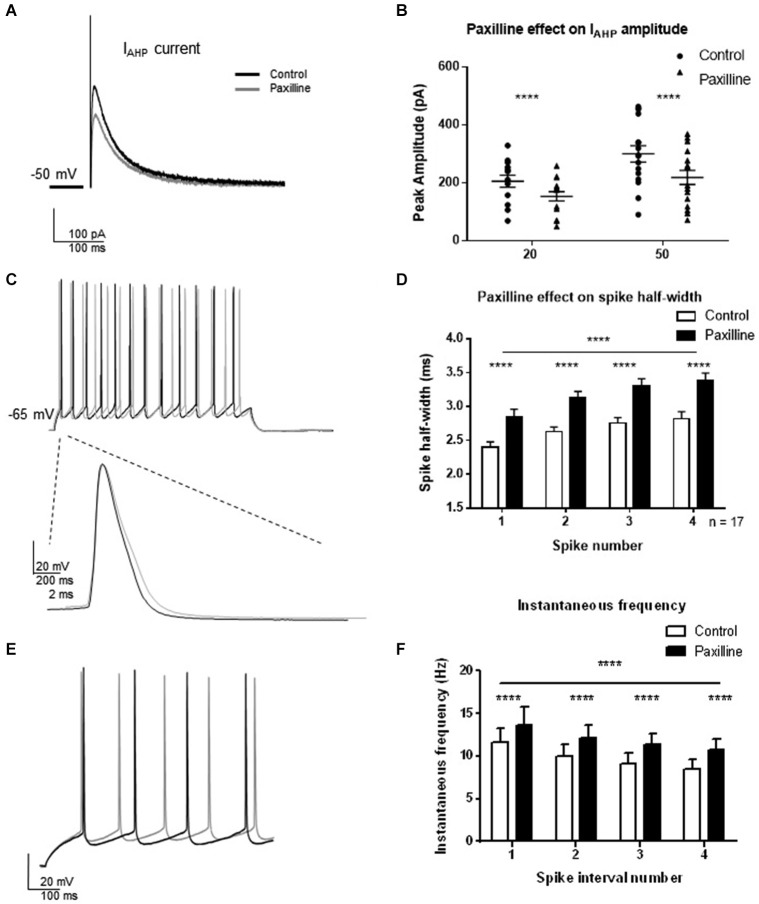
Direct blockade of BK channels with paxilline application decreased IAHP and increased spike half-width and instantaneous frequency. (A) Paxilline application significantly reduced IAHP amplitude compared to control at the 20 and 50 ms pulse lengths. Individual example showing reduced IAHP tail current in response to paxilline application (gray) compared to control (black). (B) Summary bar graph showing IAHP amplitude in control (filled circles) and paxilline (closed triangles). Paxilline had a significant effect on IAHP amplitude at both the 20 and 50 ms depolarization (paired t-test, ****p < 0.0001). (C) Paxilline application resulted in a significant increase in spike half-width of the first four spikes in the spike train. Example of paxilline (gray) effect on the first spike compared to control (black). (D) Summary bar graph showing the effect of paxilline (black bars) across the first four spikes compared to control (white bars; (****p ≤ 0.0001). Significant spike broadening was observed across the train (****p < 0.0001). No significant interaction of paxilline application and spike number was observed. Data are reported as mean ± SEM. (E) Example of effect of paxilline application on spike instantaneous frequency in response to 100 pA depolarization. Paxilline application (gray) caused an increase in instantaneous frequency compared to control (black). (F) Summary bar graph showing the effect of paxilline (black bars) on the instantaneous frequency of the first five spikes compared to control (white bars). A decrease in instantaneous frequency was observed across interval number. Data are reported as mean ± SEM, (****p < 0.0001).